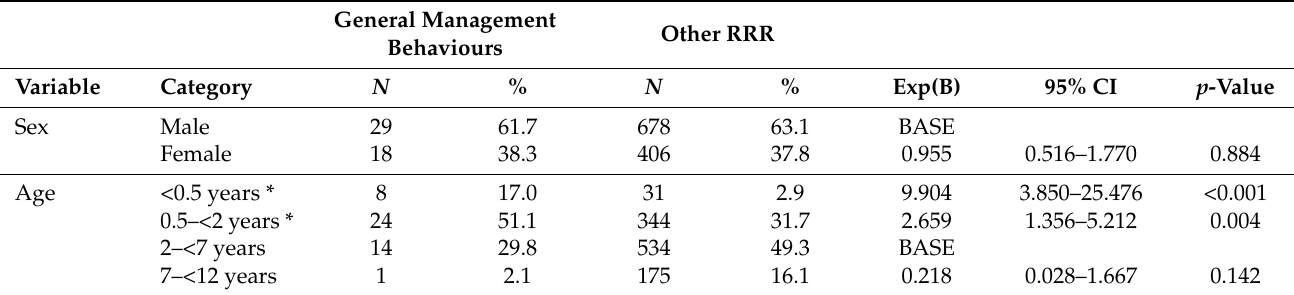
Table 6. Descriptive statistics and multivariate logistic model for dog characteristic variables associated with request for relinquishment due to problems with general management behaviour among dogs presented for relinquishment due to behavioural